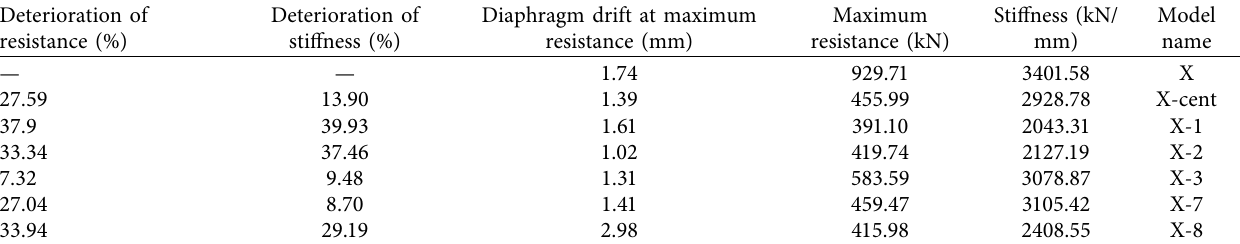
Table 5: Obtained parameters from models with opening with different layouts with loading in X direction. Deterioration of resistance